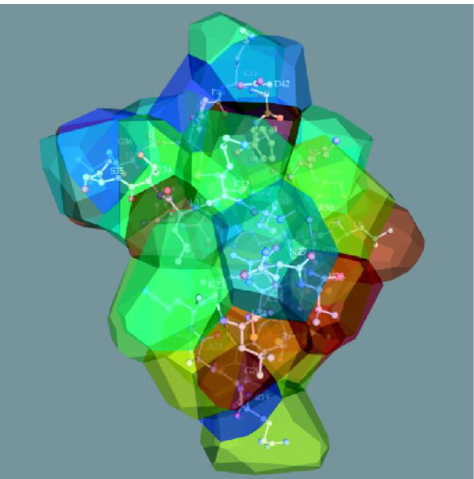
Figure 19. The structure of beta-purothionin in the form of a 3D Voronoi diagram, which was built